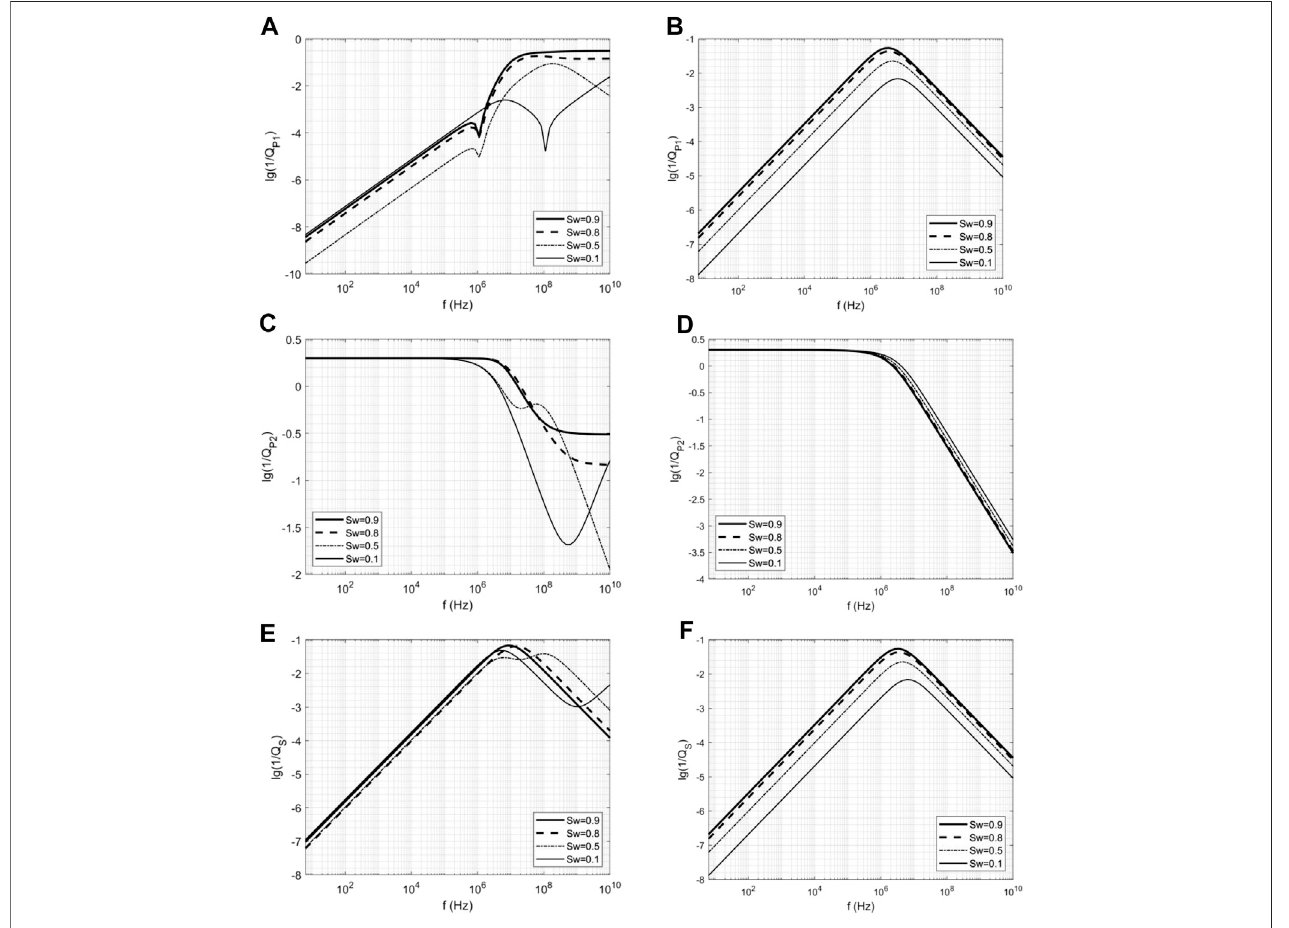
FIGURE4| Theattenuationcurveofseismicwavepropagationinaporousmediumcontainingoilandwater. (A,C,E) aretheattenuationcurvesofthefastP-wave, the slow P-wave and the S-wave corresponding to four saturations calculated by Eq. 1 , respectively; (B, D, F) are those of results by the improved model proposed in this